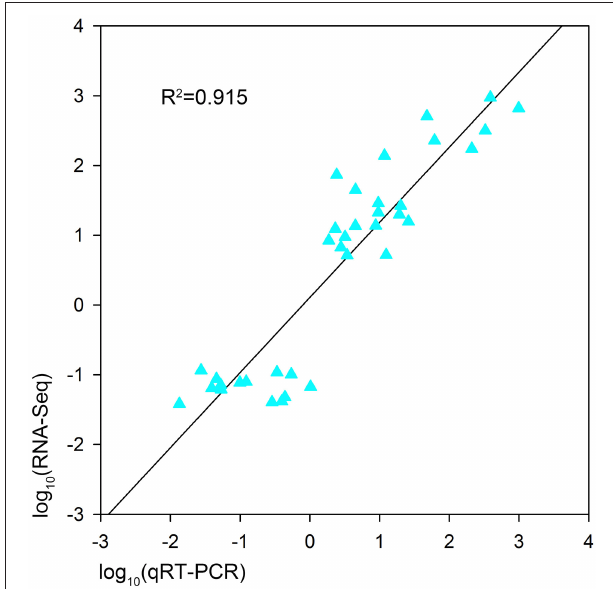
FIGURE 6 | Pearson’s correlation between the expression profiles of 18 genes by qRT-PCR and RNA sequencing (RNA-seq) in two B. napus accessions (L72: MUTU and L106: Alku). A significant positive correlation is shown ( R 2 = 0.915 , P < 0.01 ).